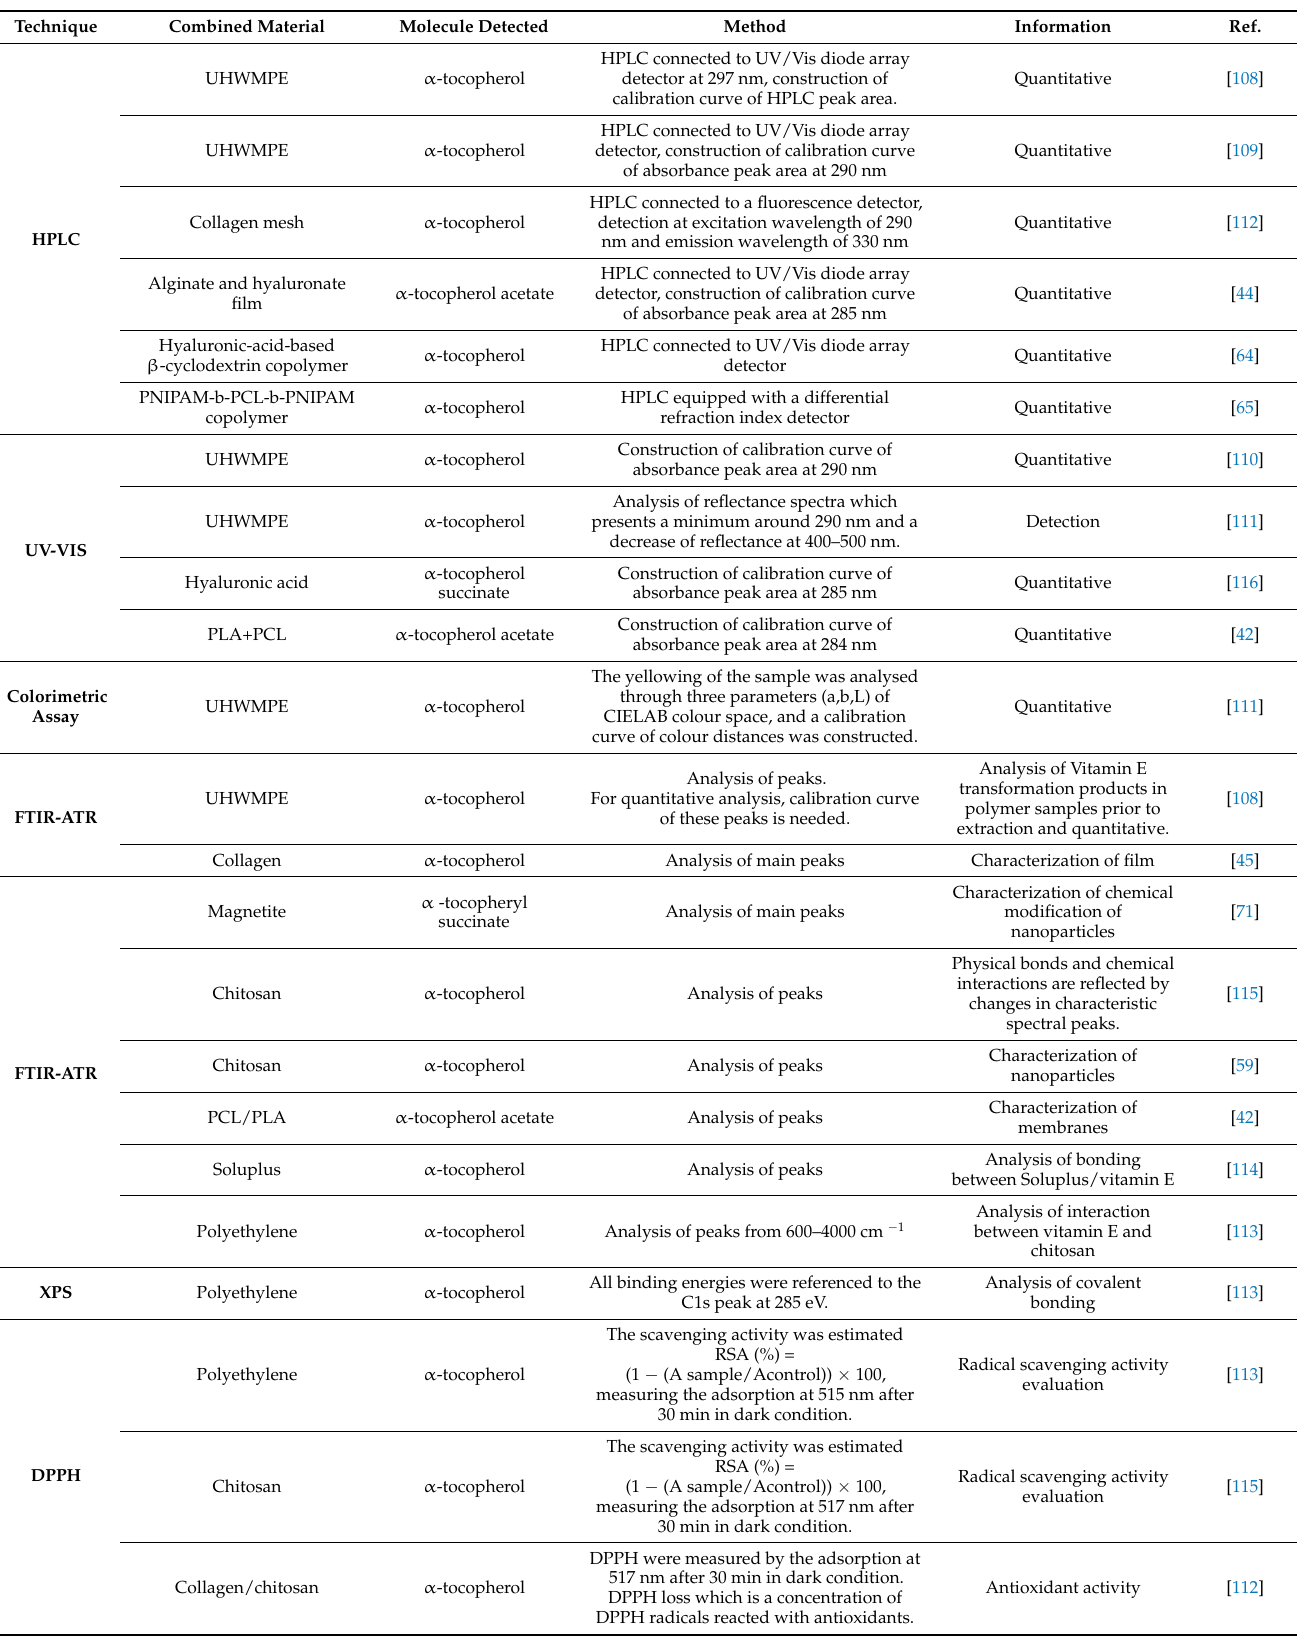
Table 4. Method of Vitamin E detection when it is combined with